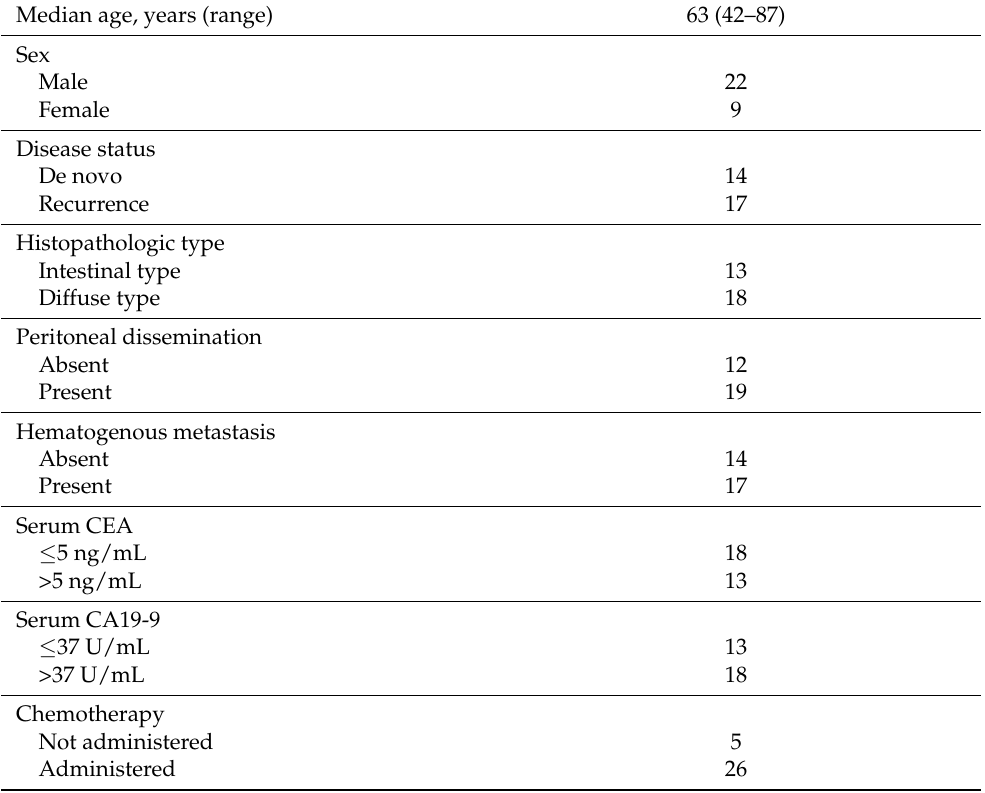
Table 1. Clinicopathologic characteristics of the 31 patients with metastatic gastric